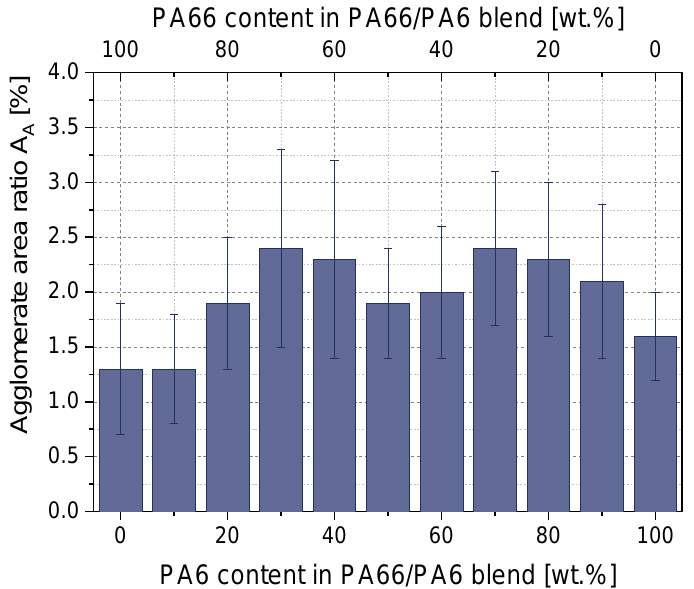
Figure 6. Agglomerate area ratio A A of PA6/PA66/1 wt % MWCNT blends with different blend compositions.